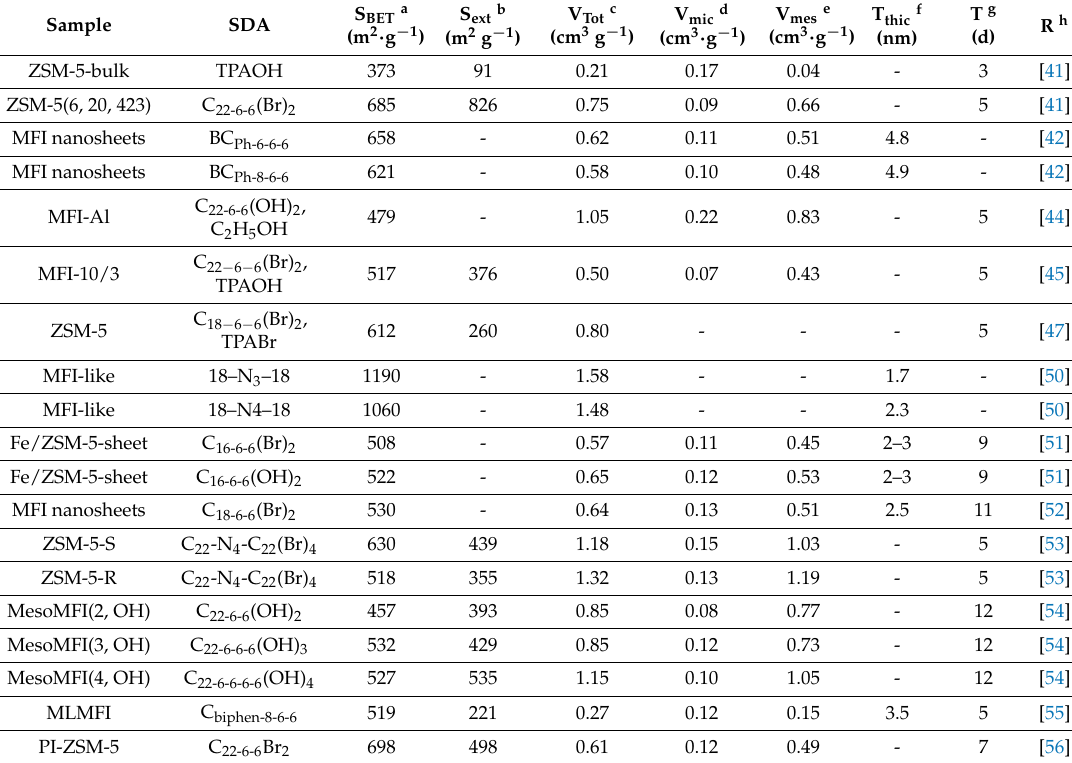
Table 2. Textural properties of the conventional ZSM-5 and MFI nanosheet zeolites in the